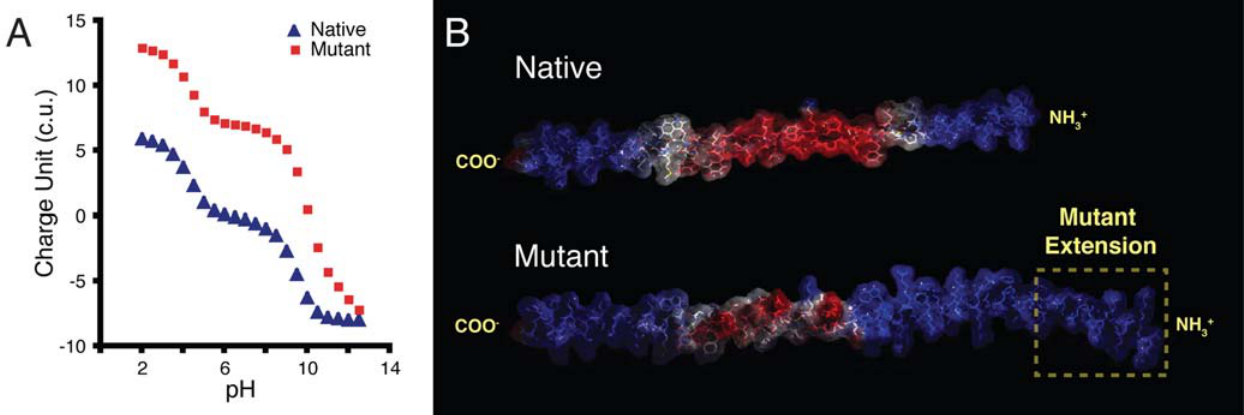
Figure 2. Calculations for native and mutant pVIII charge. (A) Theoretical calculation based on individual amino acid charge of the native and mutant pVIII protein as a function of pH. (B) pVIII structure generated using DeepView images of the native (top) and a mutant version (bottom) of the pVIII protein. The positively charged domains are shown in blue and negative ones are in red. Hydrophobic regions appear white. The native sequence was: NH 3 + -aegddpakaafdslqasateyigyawam vvvivgatigiklfkkfts-COO 2 and the mutant one was NH 3 + -PRQIKIWFQNRRMKWKKPae gddpakaafdslqasateyigyawamvvvivgatigiklfkkfts-COO 2 (capitalized residues and boxed region represent the mutant peptide extension).